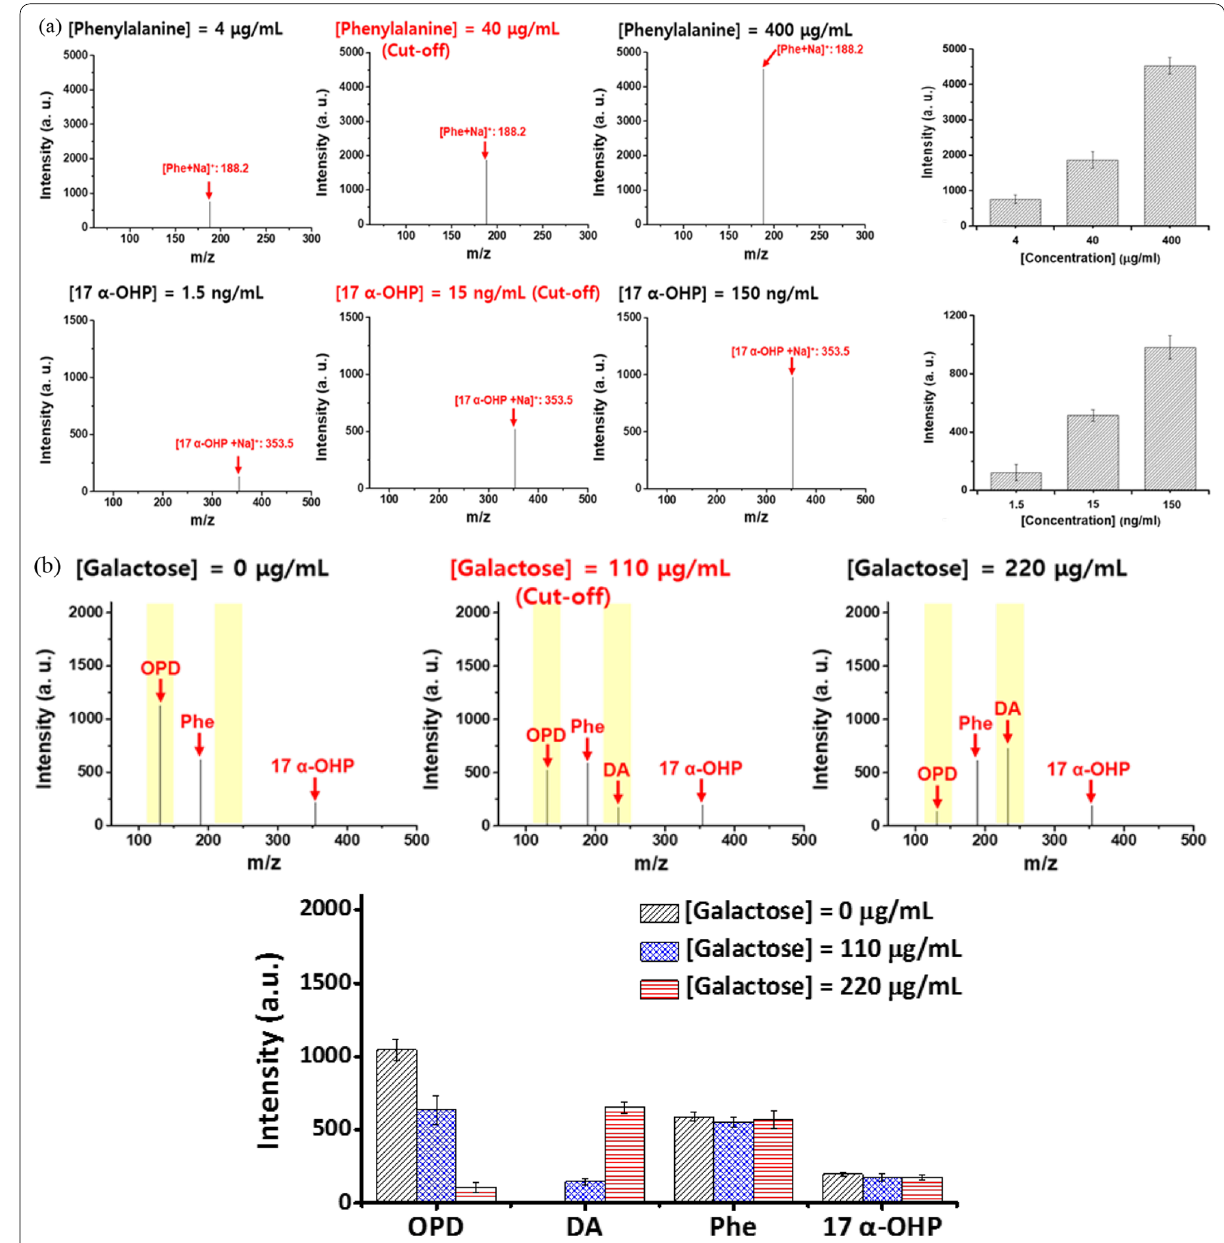
Fig. 6 Simultaneous analysis of galactose and other biomarkers (phenylalanine and 17α‑OHP) for the newborn screening test. a Mass spectra of phenylalanine and 17α‑OHP in PCB. b Mass spectra of OPD reaction products of mixtures with constant concentrations of phenylalanine and 17α‑OHP; the concentration of galactose was changed in the range around the cutoff value. c Mass spectra of OPD reaction products of mixtures with constant concentrations of galactose and 17α‑OHP; the concentration of phenylalanine was changed in the range around the cutoff value. d Mass spectra of OPD reaction products of mixtures with constant concentrations of phenylalanine and galactose; the concentration of 17α‑OHP was changed in the range around the cutoff